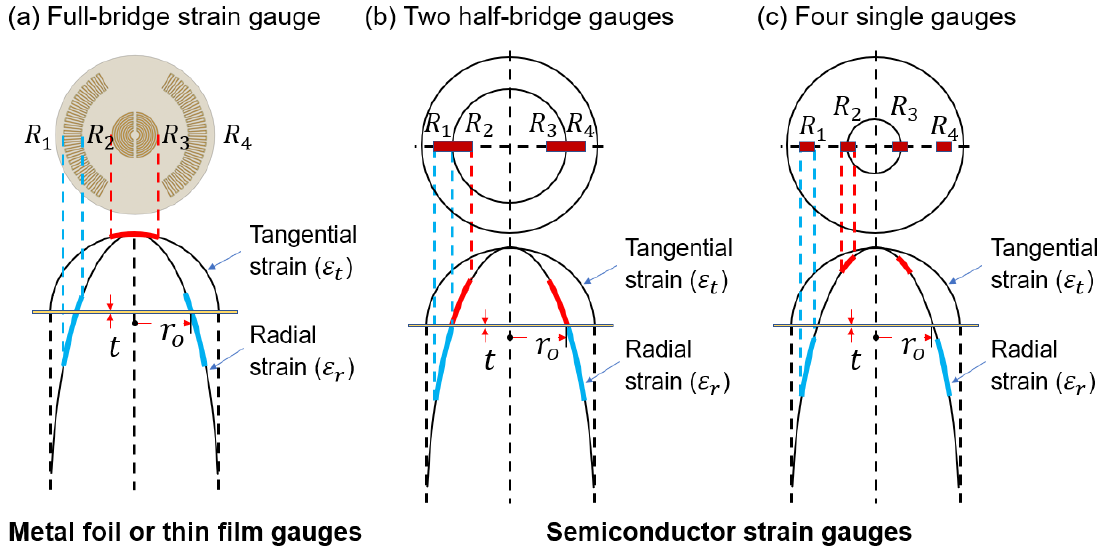
Figure 1. Examples of positions of strain gauges on a pressure-sensing circular diaphragm: ( a ) full-bridge metal foil or thin film gauges; ( b ) two silicon half-bridge gauges; and ( c ) four single silicon gauges.